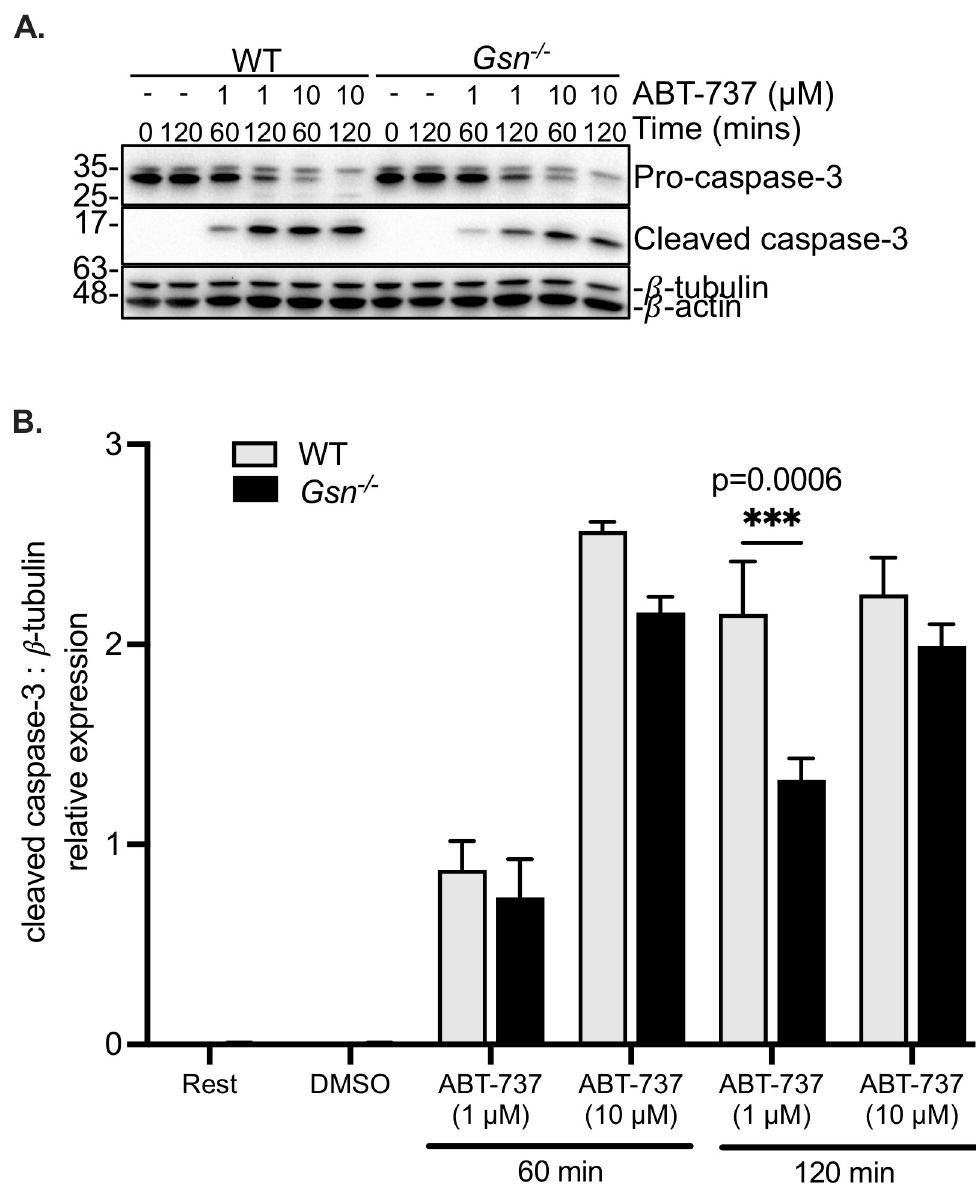
Fig 7. ABT-737-induced caspase-3 cleavage in mouse platelets is unchanged by the loss of gelsolin. A . Washed wild- type ( WT ) and gelsolin-null ( Gsn -/- ) platelets were treated with DMSO vehicle alone, with 1 μ M ABT-737 or with 10 μ M ABT, for 60 or 120 minutes as indicated. Equal amounts of lysate were resolved by SDS-PAGE; immunoblots were probed for pro-caspase-3 and cleaved caspase-3. Beta-actin ( β -actin) and beta-tubulin ( β -tubulin) are shown as loading controls. B . Bar graph depicts caspase-3 cleavage (normalized to beta-tubulin levels) in wild-type ( WT , grey bars) and gelsolin-null ( Gsn -/- , black bars) platelets were treated with DMSO vehicle alone, with 1 μ M ABT-737 or with 10 μ M ABT, and for 60 or 120 minutes as indicated. Data are mean ± SEM, analyzed by 2-way ANOVA and Bonferroni post-hoc multiple comparison tests, and represent a minimum of 3 independent